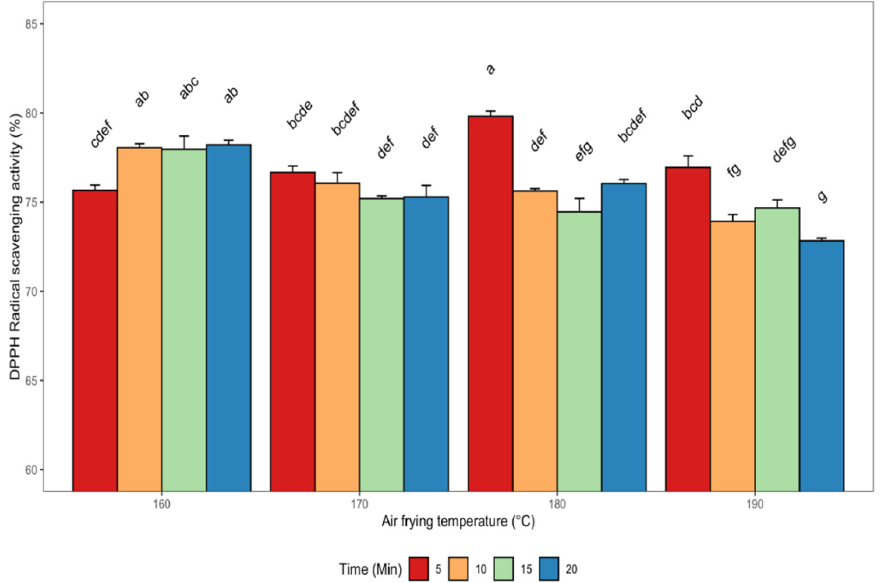
Figure 3. Changes in the DPPH free radical scavenging ability of de-oiled canola meal extracts as affected by different air frying conditions. Error bars indicate the SD of the measurements for each sample ( n = 3). Bars with different letters (a–g) have significantly ( p < 0.05) different mean values.